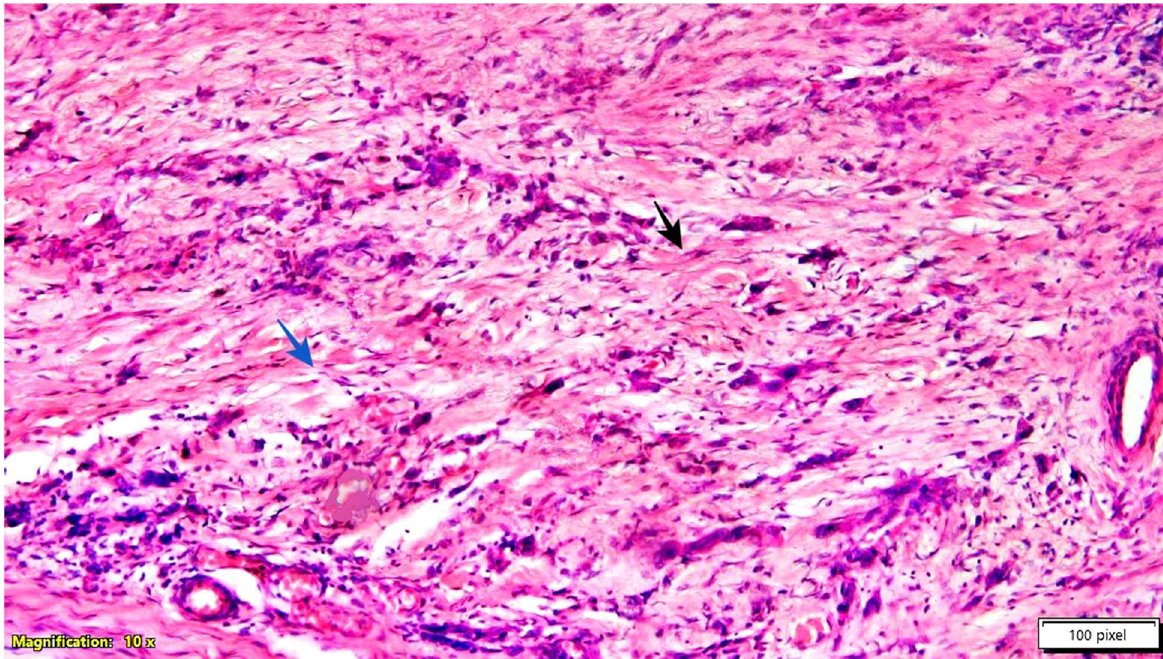
Fig. 2 Intermediate desmoplastic reaction. Broadbands of collagen with brightly eosinophilic hyalinization (black arrow) with mature collagen fibers and loose immature stroma (blue arrow) surrounding clusters of tumor cells (H&E, 10